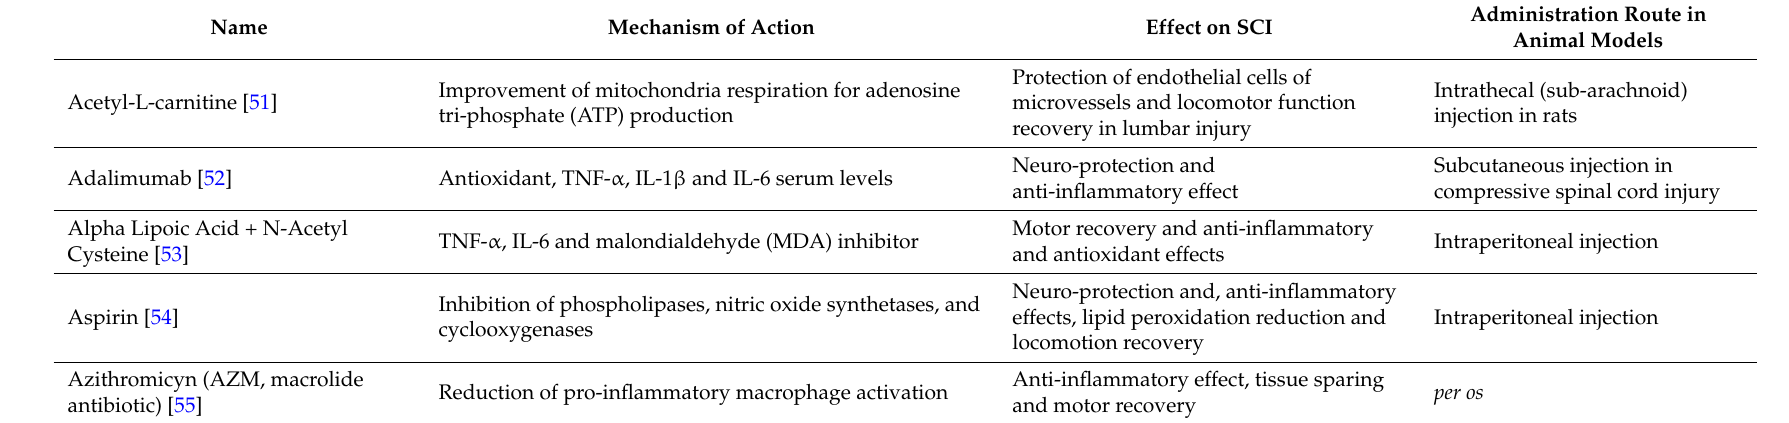
Table 3. Neuro-protective or neuro-regenerative drugs reported in the literature over the last two years as potentially effective in the treatment of